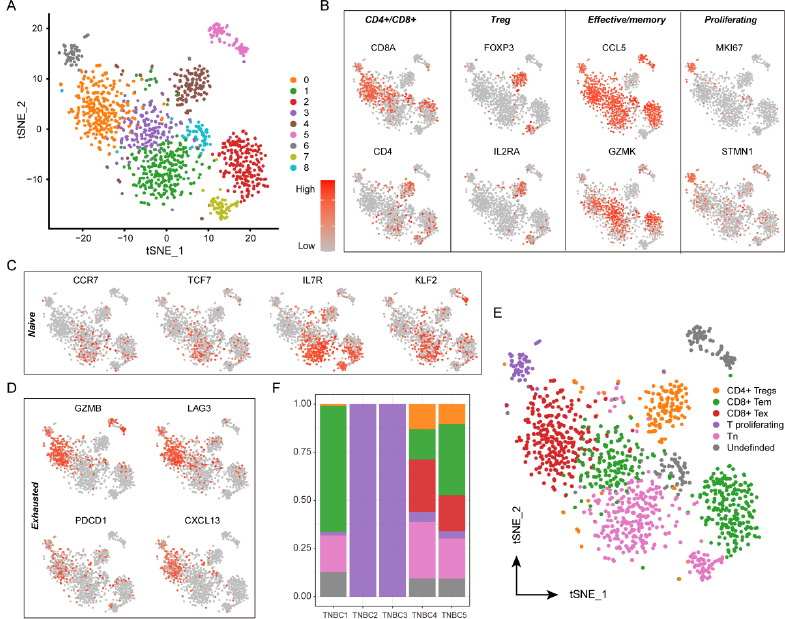
Figure 2. T-cell subpopulations and gene expression in TNBC. ( A ) t-SNE plot of the T cells in the tumors color-coded by the associated cell clusters. ( B – D ) t-SNE plot of marker genes for the T-cell subpopulations as indicated, ( B ) CD4 + /CD8 + , Treg, effective/memory, and proliferating, ( C ) naïve, and ( D ) exhausted, the shades of red indicating the gene expression levels. ( E ) t-SNE plot of the T cells in the tumors color-coded by the annotated functional T-cell subpopulations. ( F ) Relative proportions of T-cell types for each TNBC patient.